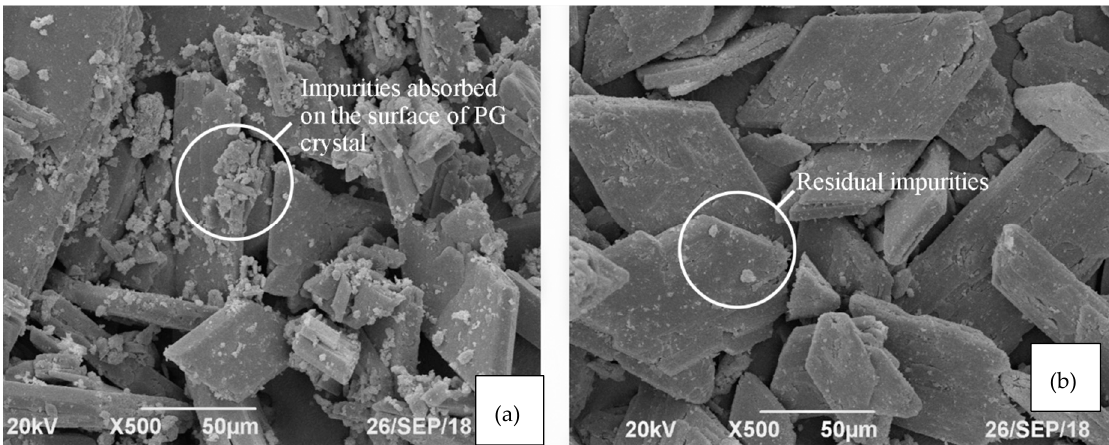
Figure 5. Scanning electron microscope (SEM) images of the OPG ( a ) and the TPG ( b ).